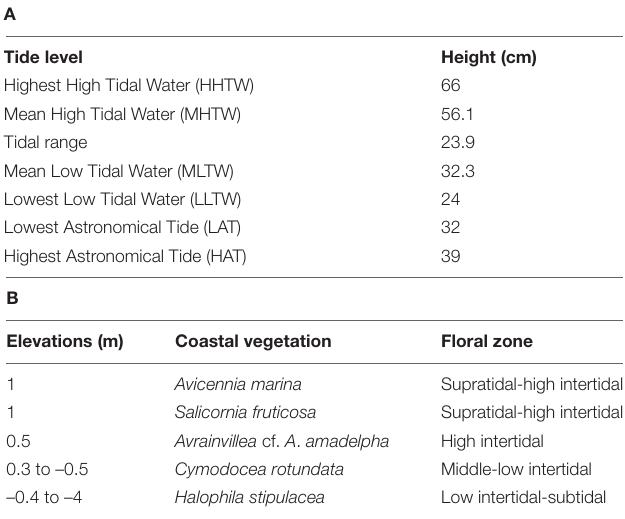
TABLE 2 | (A) Tide levels at Al-Kharrar Lagoon (Rabigh) relative to the Saudi datum (Saudi Aramco Tide Tables, 2014), (B) coastal vegetation on the supratidal intertidal sabkha of Al-Kharrar